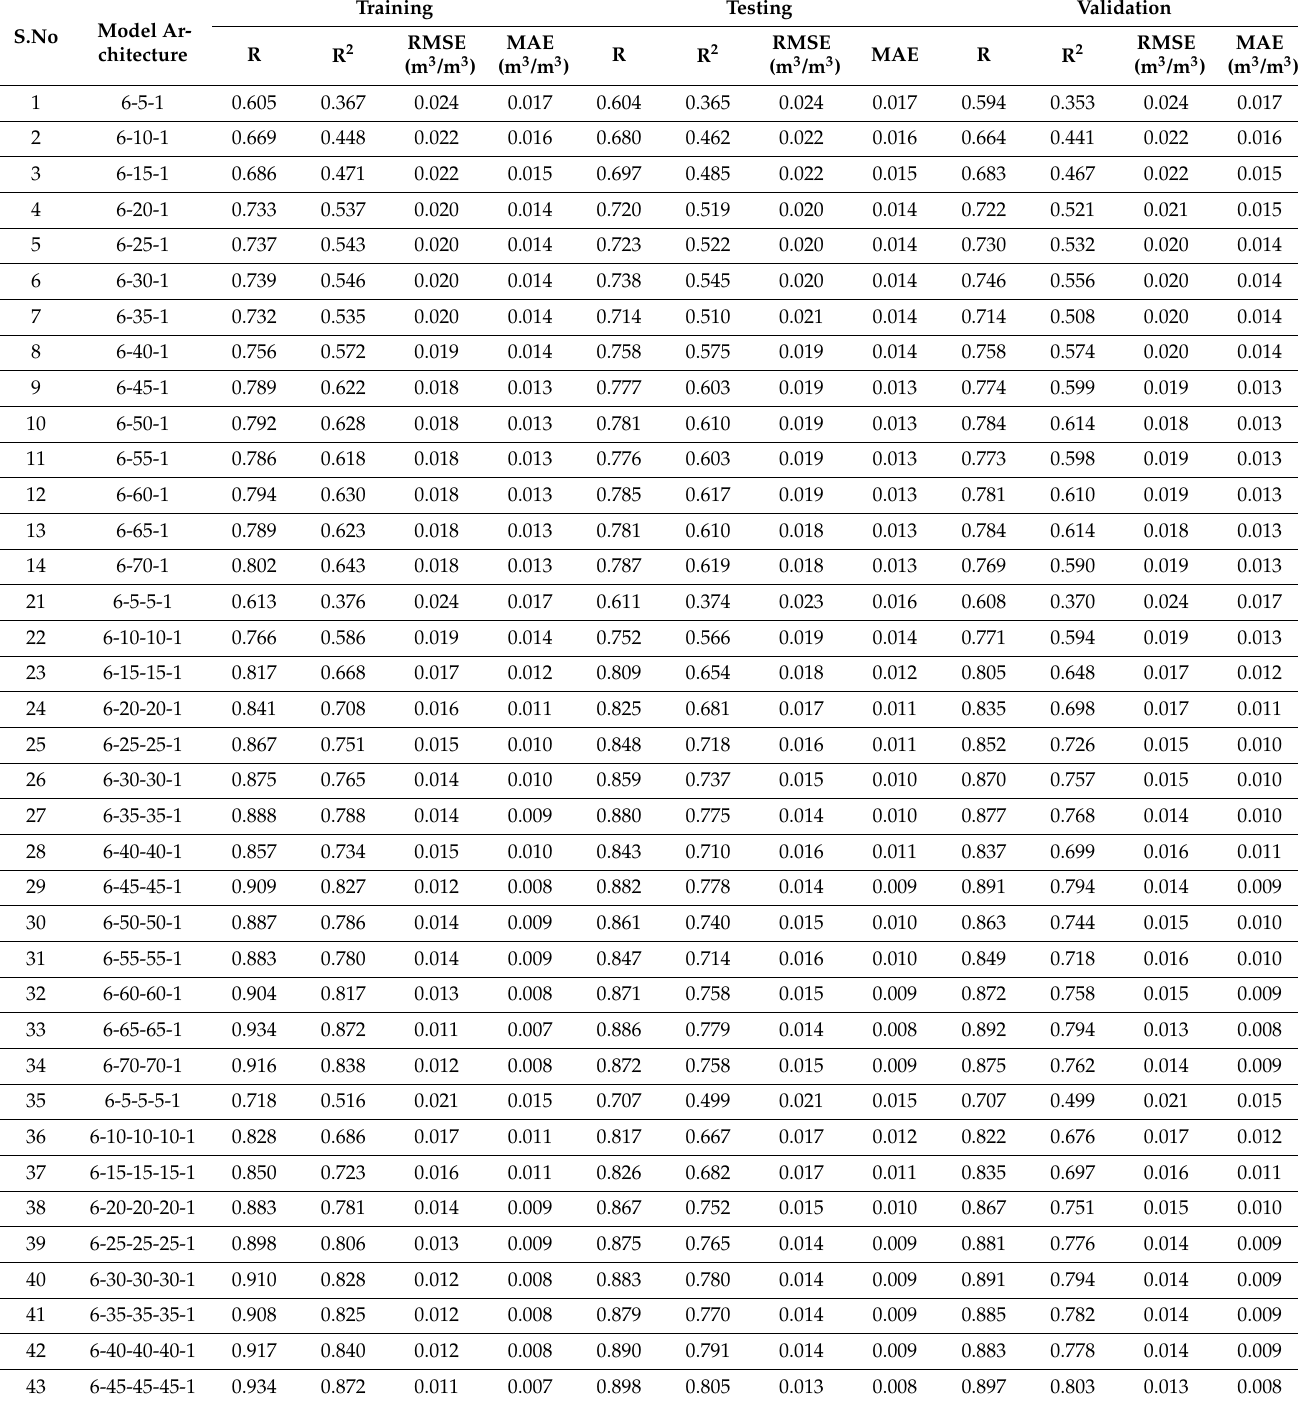
Table A1. Performance statistics of different neural network architectures tested for volumetric water content (VWC)